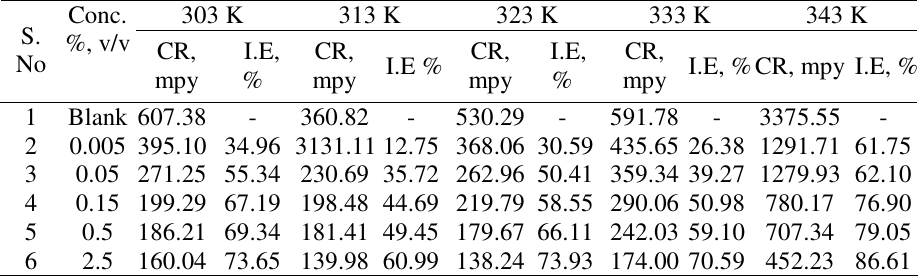
Table 3. Protection performance of CAL on MS in 1 M HCl (½ h) at different temperatures.